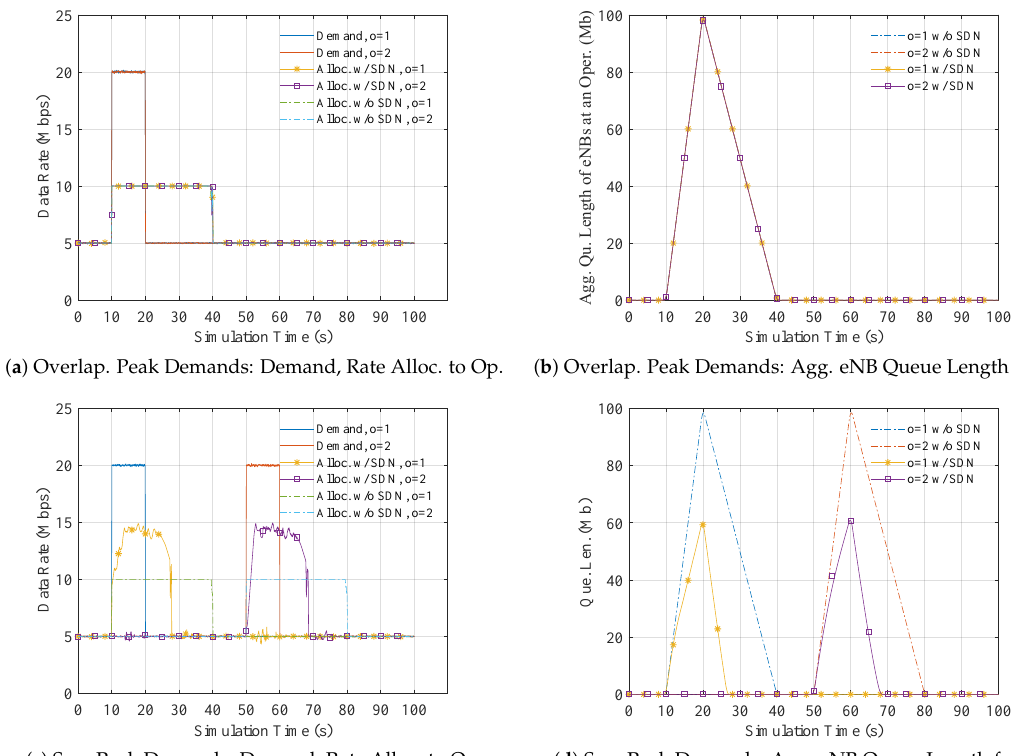
Figure 3. Upstream traffic demands and corresponding backhaul bitrate allocations to operators as well as aggregated queue length of eNBs associated with a given operator when peak demand periods of the two operators overlap or are separated (fixed parameter: Mean drift-plus-penalty parameter V = 1000): For overlapping peak demands ( a , b ), both the SDN-based optimization and the benchmark without SDN allocate to each operator its maximum capacity of Z o = 10 Mbps to serve the peak demands; there is no sharing among operators. For separated peak demands ( c , d ), the SDN orchestrator dynamically shares the total aggregated backhaul capacity of Z = 20 Mbps among the two operators, reducing eNB queue lengths compared to the benchmark without SDN-based resource